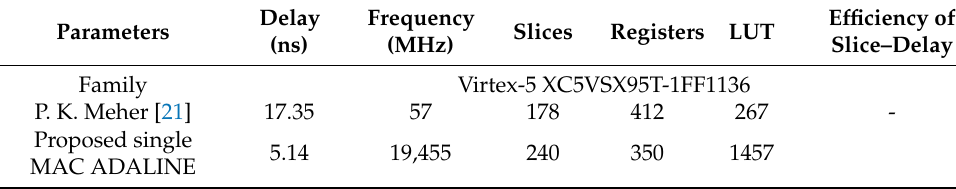
Table 4. Synthesis comparison of the existing system with the proposed architecture.